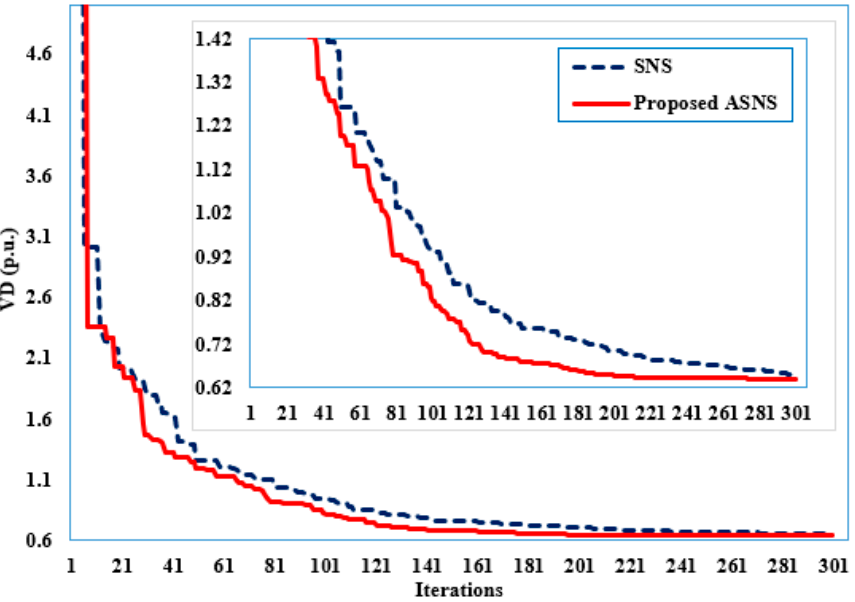
Figure 9. Convergence features of the proposed ASNS and SNS for Case 2 of the IEEE 57-bus grid.